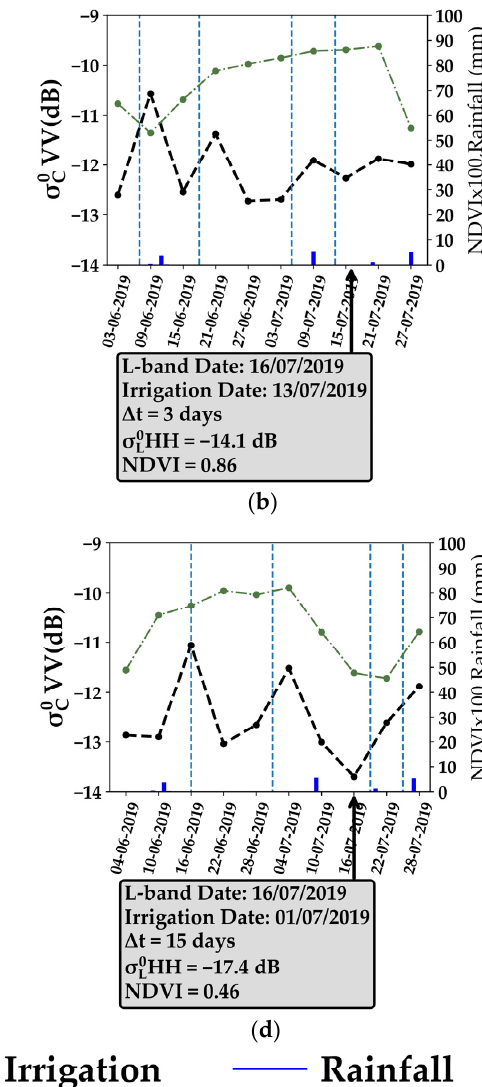
Figure 8. Temporal evolution of the S1 C-band SAR backscattering for 4 different grassland plots during the second growth cycle between June and July 2019. The green dotted line represents the S2 NDVI values multiplied by 100. The dashed blue lines represents the irrigation events and the solid blue bars represent the rainfall amounts. The grey boxes show the σ (cid:2896)(cid:2868) values derived from the ALOS-2 image acquired on 16/07/2019 with the corresponding ∆t value, the last irrigation date, and the NDVI value on 16/07/2019. ( a ) A1 at 44°, ( b ) D2 at 42°, ( c ) D1 at 32°, and ( d ) A2 at 35°. In Figure 8b, the first irrigation event that occurred on 07/06 caused an increase of 2.1 dB in the σ (cid:2887)(cid:2868) values between 03/06 and 09/06. The vegetation cover on 09/06 was still low, with an NDVI value of 0.52. σ (cid:2887)(cid:2868) then decreased with the dryness of the soil to reach − 12.5 dB on 15/06 and then increased by 1.2 dB between 15/06 and 21/06 due to an irrigation event that occurred on 18/06. The NDVI value on 21/06 reached 0.77. With the absence of irrigation between 21/06 and 03/07, the σ (cid:2887)(cid:2868) values decreased, reaching − 12.7 dB. The irri- gation event that took place on 05/07 caused an increase of 0.8 dB in the σ (cid:2887)(cid:2868) values be- tween 03/07 and 09/07 (S1 image 4 days after the irrigation), where the NDVI value on 09/07 reached 0.86. The next irrigation event on 13/07 did not show a significant increase in the σ (cid:2887)(cid:2868) values, which slightly decreased by 0.3 dB to reach − 12.2 dB with an NDVI of 0.86. The L-band image acquired on 16/07, 3 days after the last irrigation on 13/07, shows a σ (cid:2896)(cid:2868) value of − 14.1 dB with an NDVI value 0.86. In Figure 8c, the 2 irrigation events that took place on 14/06 and 20/06 caused the σ (cid:2887)(cid:2868) values to increase by 1.1 and 2 dB between 08/06–14/06 and 14/06–20/06, respectively (both irrigations on the same day as the S1 acquisitions). NDVI also increased from 0.47 on 08/06 to reach 0.69 on 20/06. The σ (cid:2887)(cid:2868) values then decreased by 1.5 dB on 26/06 due to the dryness of the soil and then increased by 1.1 dB on 02/07, with an irrigation event occurring on the same day as the S1 acquisition. The NDVI value on 02/07 reached 0.85. Six days later, the σ (cid:2887)(cid:2868) decreased sharply with no irrigation to reach − 12.3 dB on 08/07. The irrigation events that took place on 11/07, 3 days before the S1 acquisition on 14/07, caused an increase of 0.8 dB in the σ (cid:2887)(cid:2868) values between 08/07 and 14/07. σ (cid:2887)(cid:2868) then increased by 1.3 dB due to irrigation that took place on 18/07 2 days before the S1 acquisition on 20/07. The last irri- gation event that took place on 25/07 maintained the σ (cid:2887)(cid:2868) values at a high level between 20/07 ( − 10.5 dB) and 26/07 ( − 10.8 dB). The L-band image on 16/07, 5 days after the irriga- tion on 11/07, shows a σ (cid:2896)(cid:2868) value of − 14.7 dB, with an NDVI of 0.84. Figure 8d shows that σ (cid:2887) (cid:2868) increased from − 12.9 dB on 10/06 to − 11.0 dB on 16/06 (in- crease of 1.9 dB) due to the irrigation event that occurred on 16/06 (same day as the S1 image). NDVI on 16/06 reached 0.74. The σ (cid:2887)(cid:2868) value then decreased to reach − 13.0 dB on